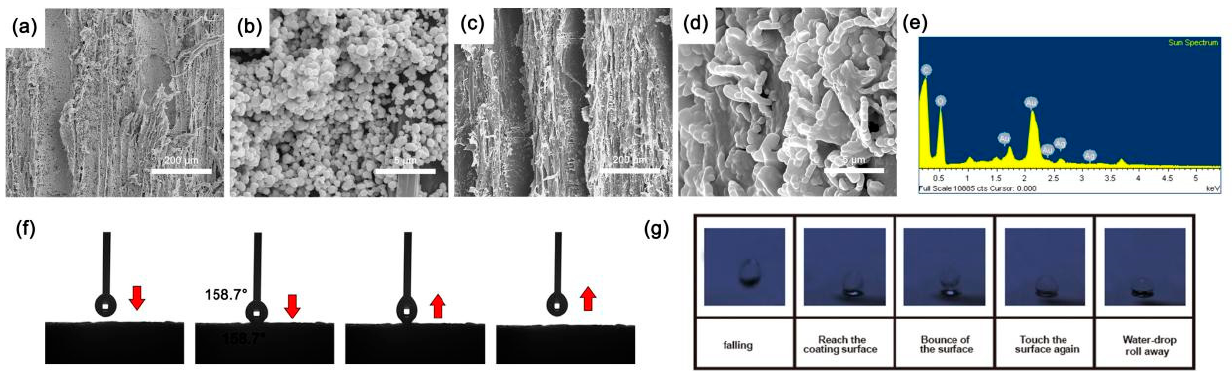
Figure 4. ( a ) SEM images of wood@Ag at 200 magnification; ( b ) SEM images of wood@Ag at 8000 magnification; ( c ) SEM